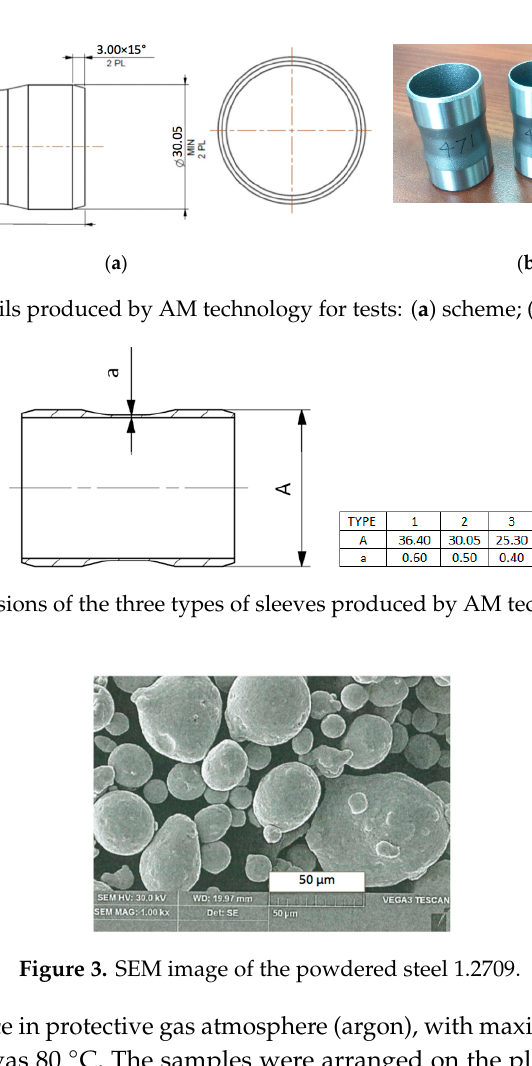
Figure 3. SEM image of the powdered steel 1.2709.